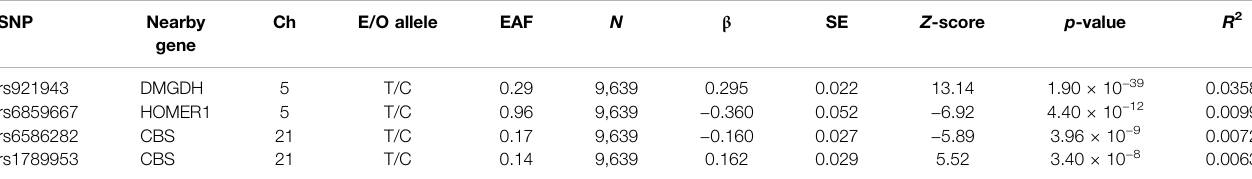
TABLE 1 | SNPs signi fi cantly associated with selenium levels and included in the MR